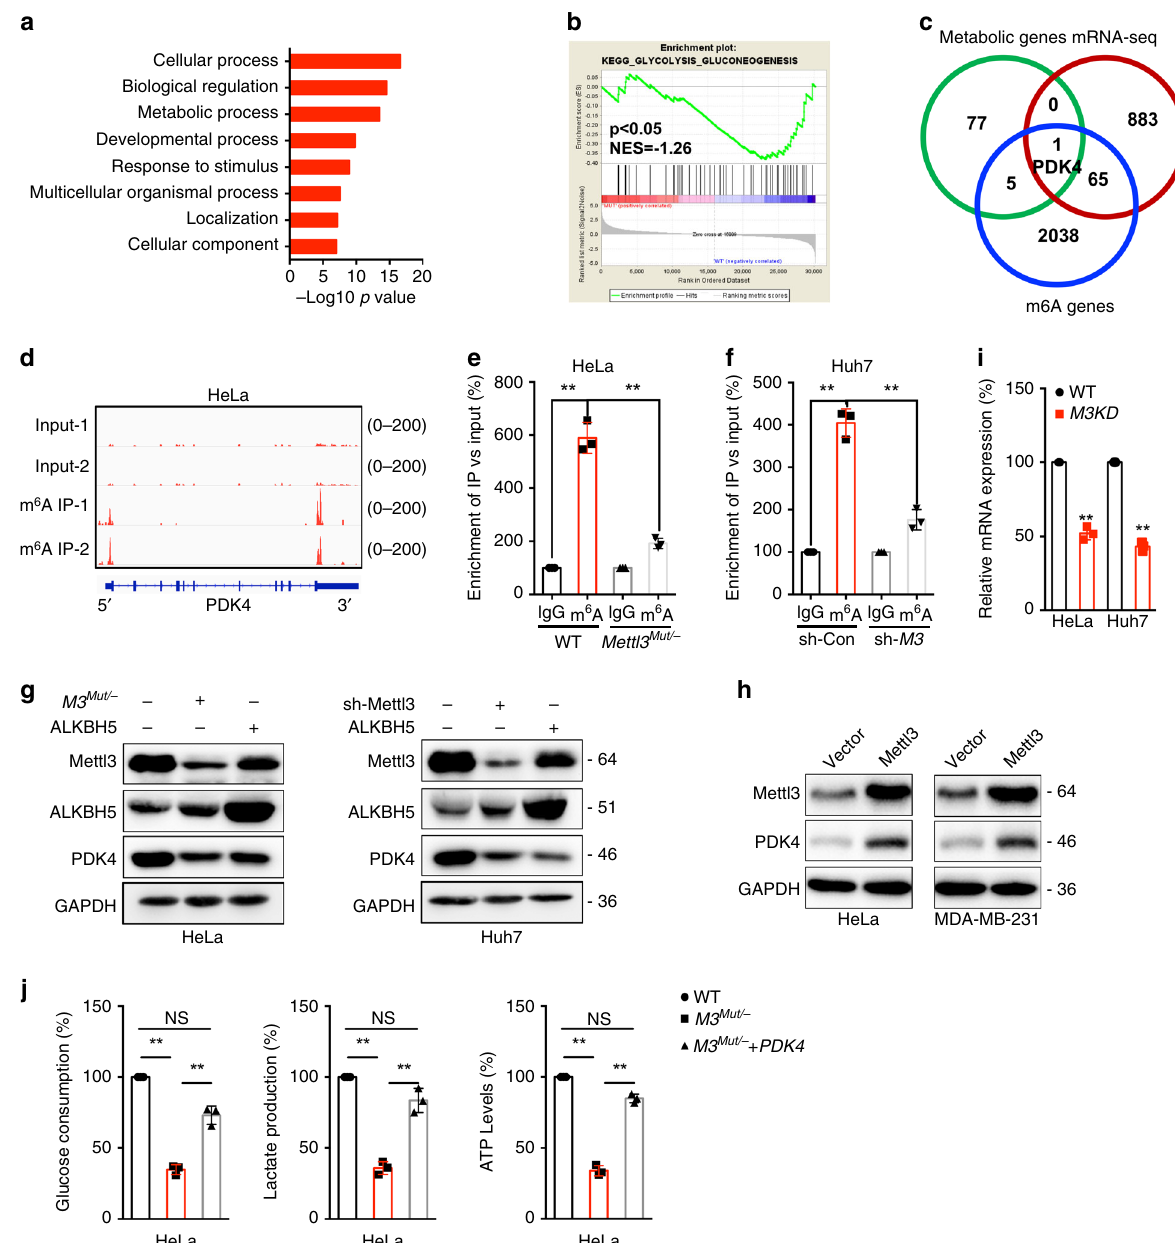
Fig. 2 PDK4 mediates m 6 A regulated glycolysis and ATP generation of cancer cells. a Gene ontology analysis was performed on a subset of downregulated genes in Mettl3 Mut/- HeLa cells. Log2 fold change, (KD: WT) < − 0.5, was applied as the threshold cutoff. Several biological processes involved in metabolic processes were enriched and highlighted in bold; Signi fi cance shown as – Log10 Bonferroni p -value after multiple hypothesis correction. b GSEA reveals negative enrichment of genes in glycolysis gluconeogenesis sets of Mettl3 Mut/- HeLa cells. c Venn diagram shows substantial and signi fi cant overlap among metabolic genes, variated genes in Mettl3 Mut/- HeLa cells (>2 folds), and m 6 A enriched genes in wild type HeLa cells (>3 folds than input). d m 6 A peaks were enriched in 5 ′ UTR and 3 ′ UTRs of PDK4 genes from m 6 A RIP-seq data; e m 6 A RIP-qPCR analysis of PDK4 mRNA in wild type and Mettl3 Mut/- HeLa cells. f m 6 A RIP-qPCR analysis of PDK4 mRNA in sh-Con and sh- Mettl3 Huh7 cells. g The expression of PDK4 in Mettl3 Mut/- HeLa, sh-Mettl3 Huh7, or over expression of ALKBH5 and their corresponding control cells were measured by western blot analysis. h Cells were transfected with vector control or Mettl3 construct for 24 h, the expression of PDK4 was measured. i The mRNA of PDK4 in Mettl3 Mut/- HeLa, sh- Mettl3 Huh7 and their corresponding control cells were measured by qRT-PCR. j The glucose consumption, lactate production, and ATP levels in wild type or Mettl3 Mut/- HeLa cells transfected with PDK4 constructs for 24 h. Data are presented as the mean ± SD from three independent experiments. A representative from a total of two to three independent experiments is shown for ( g ) and ( h ). ** p < 0.01, NS, no signi fi cant, by random permutation test for ( b ), by two-way ANOVA for ( e ) ( p = 0.0001 and p = 0.0004, respectively) and ( f ) ( p < 0.0001 and p = 0.0007, respectively), two-tailed unpaired Student ’ s t test for ( i ) ( p < 0.0001), and one-way ANOVA for ( j ) ( p < 0.0001 and p = 0.0008 for glucose consumption, p < 0.0001 and p = 0.0011 for lactate production, and p < 0.0001 for ATP levels,